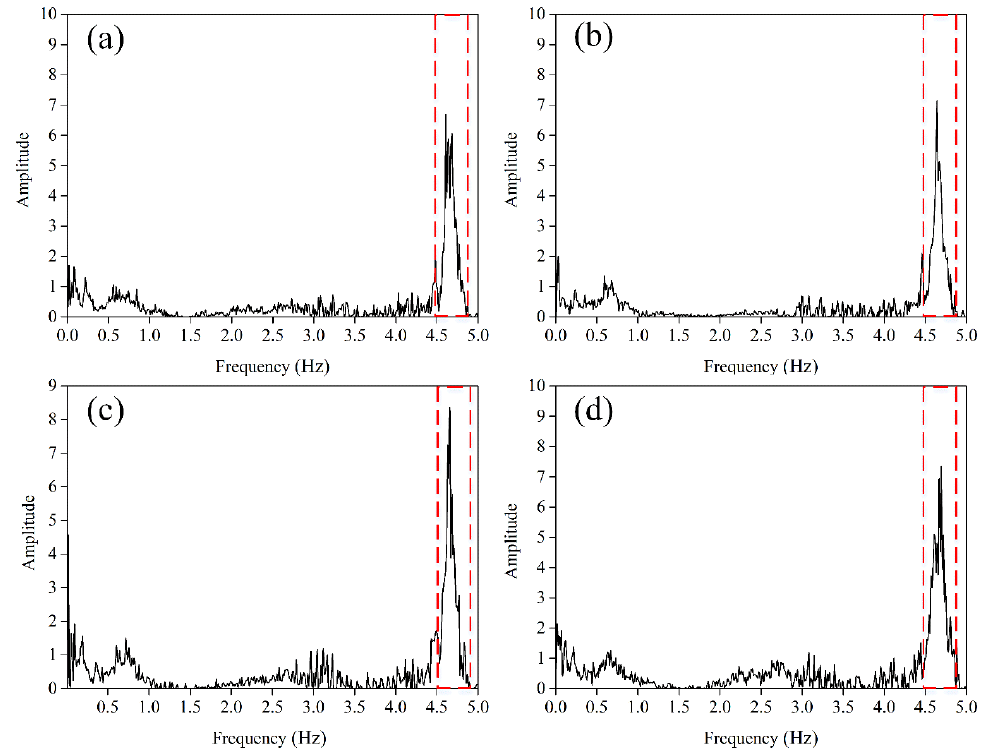
Figure 13. Marginal spectrum maximum value of FAP after dressing with AWJ under four pressures: ( a ) 2 MPa; ( b ) 3 MPa; ( c ) 4 MPa; ( d ) 5 MPa.